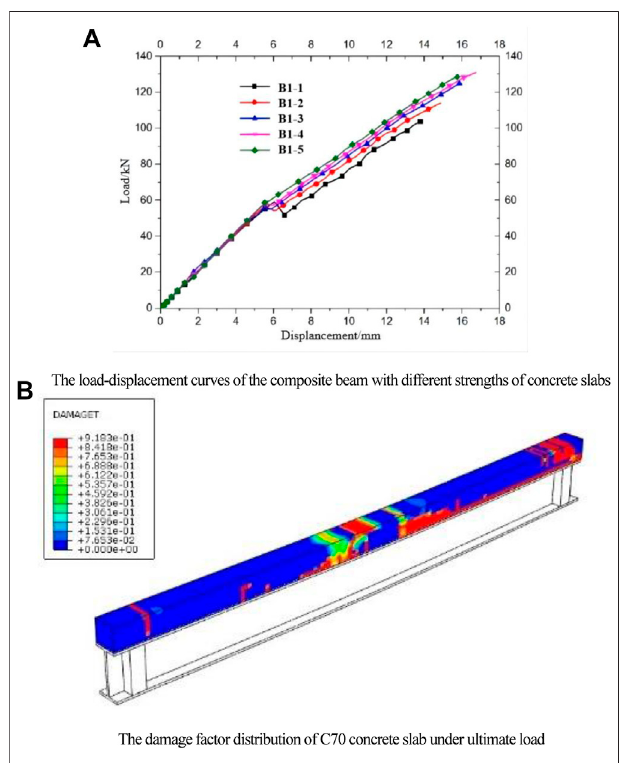
FIGURE 8 | Effect of concrete strength on the mechanical properties of the composite beam. (A) Load – displacement curves of the composite beam withdifferentstrengthsofconcreteslabs. (B) Damagefactordistributionofthe C70 concrete slab under ultimate